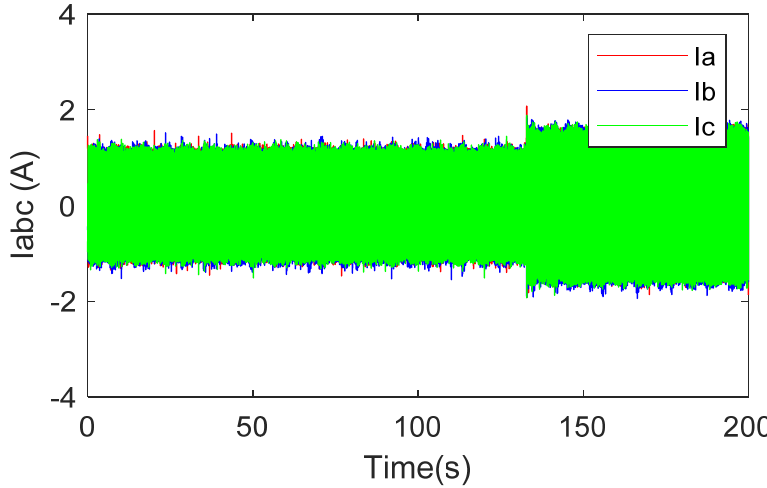
Figure 17. Three-phase PMSG currents with variable load demand.